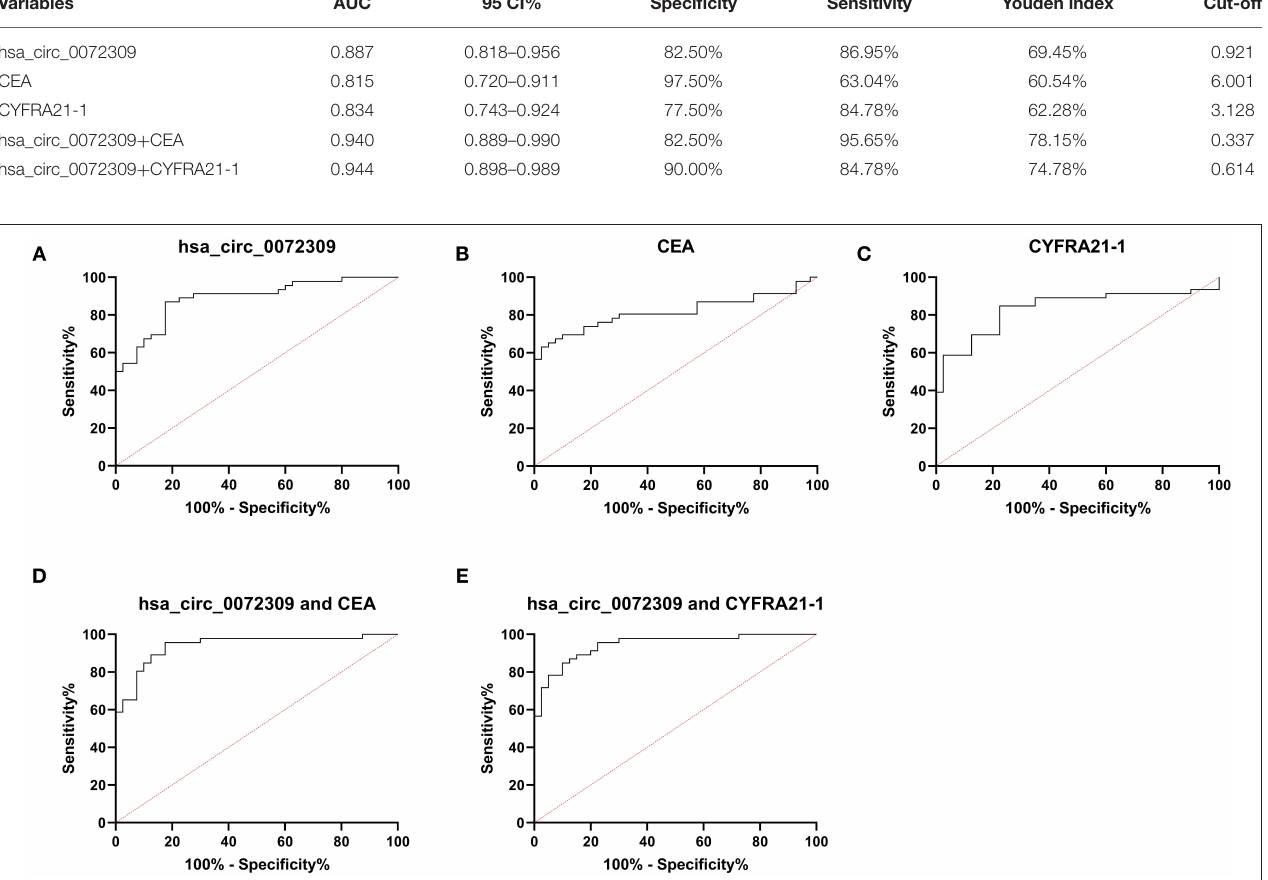
FIGURE 5 | hsa_circ_0072309 for NSCLC diagnosis by ROC analysis. (A) . hsa_circ_0072309’s implications for NSCLC diagnosis by ROC. (B) . CEA’s implications for NSCLC diagnosis by ROC. (C) . CYFRA21-1’s implications for NSCLC diagnosis by ROC. (D) . Diagnosistic implications of hsa_circ_0072309 + CEA for NSCLC by ROC. (E) . Diagnosistic implications of hsa_circ_0072309 + CYFRA21-1 for NSCLC by ROC.